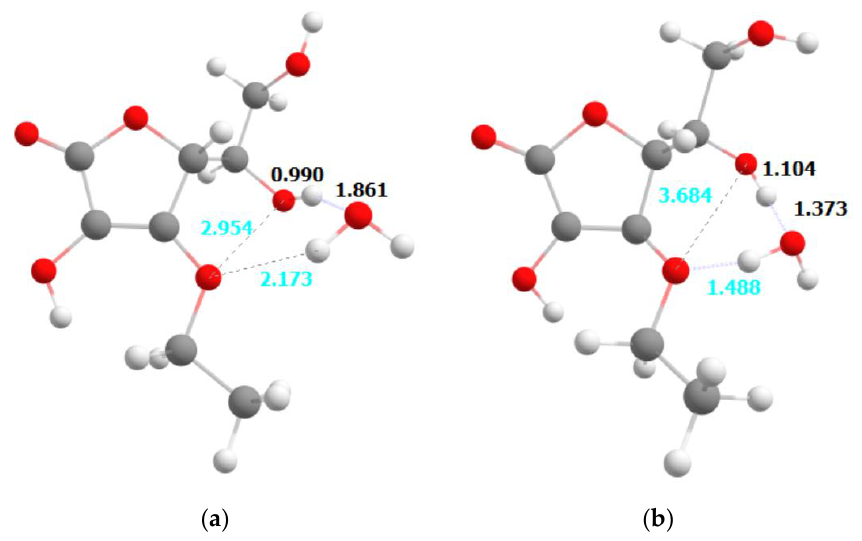
Figure 8. The optimized geometries of the ethylated form of the ascorbic acid in its ground electronic state ( a ) and the first excited singlet state ( b ).